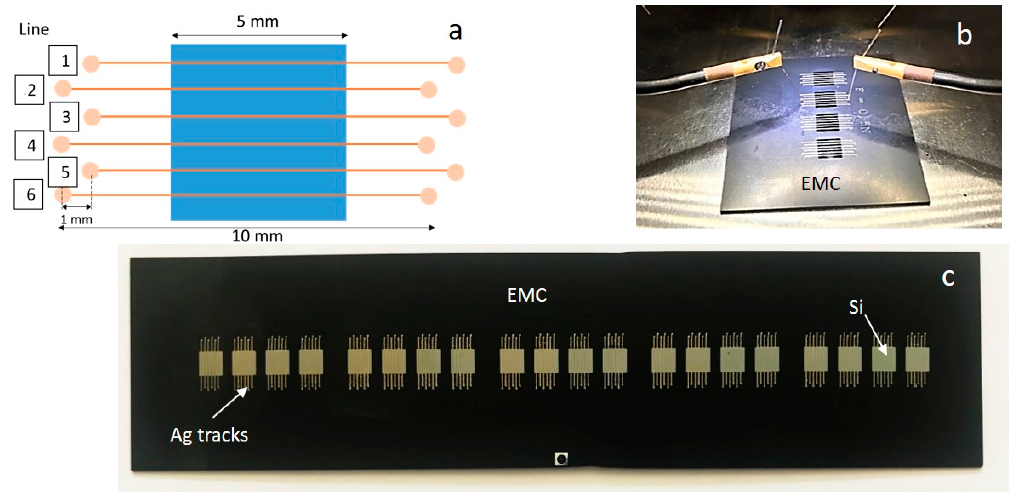
Figure 8. Schematic ( a ) and experimental setup ( b ) for temperature cycling test. An example of the test sample arrays for temperature cycling test is shown in ( c ).